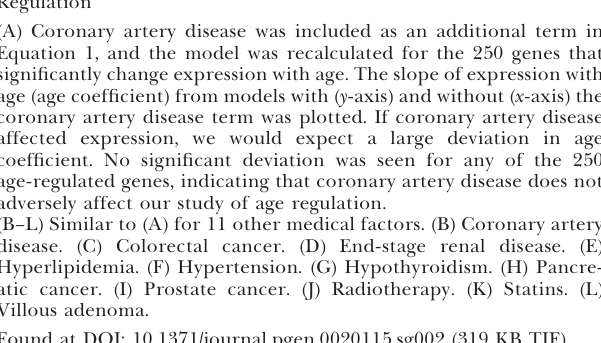
Figure S1. Age Distribution of Anatomical, Medical, and Pharma- ceutical Factors Each row denotes a medical or pharmaceutical factor. Age of patients is shown on the x -axis. Sex, biopsy location, and 12 medical factors are shown in the legend. Only hypothyroidism shows any overt association with age. Found at DOI: 10.1371/journal.pgen.0020115.sg001 (253 KB TIF). Figure S2. Medical and Pharmaceutical Factors do not Affect Age Regulation (A) Coronary artery disease was included as an additional term in Equation 1, and the model was recalculated for the 250 genes that significantly change expression with age. The slope of expression with age (age coefficient) from models with ( y -axis) and without ( x -axis) the coronary artery disease term was plotted. If coronary artery disease affected expression, we would expect a large deviation in age coefficient. No significant deviation was seen for any of the 250 age-regulated genes, indicating that coronary artery disease does not adversely affect our study of age regulation. (B–L) Similar to (A) for 11 other medical factors. (B) Coronary artery disease. (C) Colorectal cancer. (D) End-stage renal disease. (E) Hyperlipidemia. (F) Hypertension. (G) Hypothyroidism. (H) Pancre- atic cancer. (I) Prostate cancer. (J) Radiotherapy. (K) Statins. (L) Villous adenoma. Found at DOI: 10.1371/journal.pgen.0020115.sg002 (319 KB TIF). Figure S3. Cluster Analysis of Medical and Pharmaceutical Factors Samples are clustered on the basis of 250 age-regulated genes in muscle, shown by the top dendrogram. Columns are individual muscle samples, marked by age of the patient. Top seven rows correspond to the expression of the first seven age-regulated genes. The diagram shows anatomical, medical, and pharmaceutical factors for each patient. Each row corresponds to one medical or pharmaceutical factor. Found at DOI: 10.1371/journal.pgen.0020115.sg003 (1.2 MB TIF). Table S1. Clinical Data Found at DOI: 10.1371/journal.pgen.0020115.st001 (2.1 MB XLS). Table S2. 250 Age-Regulated Genes ( p , 0.001), Arranged by Slope with Age Table S3. 624 Gene Sets Assayed for Age Regulation Table S4. Contributing Genes in Gene Sets Age Regulated in Muscle Table S5. Type II/Type I Muscle Fiber Diameter Ratios of 32 Patients Table S6. 92 Age-Regulated Genes that Predict Type II/Type I Ratio Table S7. 114 Type II/Type I–Regulated Genes that Predict Age Table S8. Significant Overlap between Sets of Age-Regulated and Type II/Type I–Regulated Genes Table S9. Contributing Genes in Gene Sets Commonly Age Regulated in Muscle, the Kidney, and the Brain Table S10. Aging Coefficients of 11,512 Genes in Mouse Kidneys Table S11. Correlation of Age-Regulated Genes in Three Tissues Table S12. Spearman Correlations between Tissues for Age-Regu- lated Gene